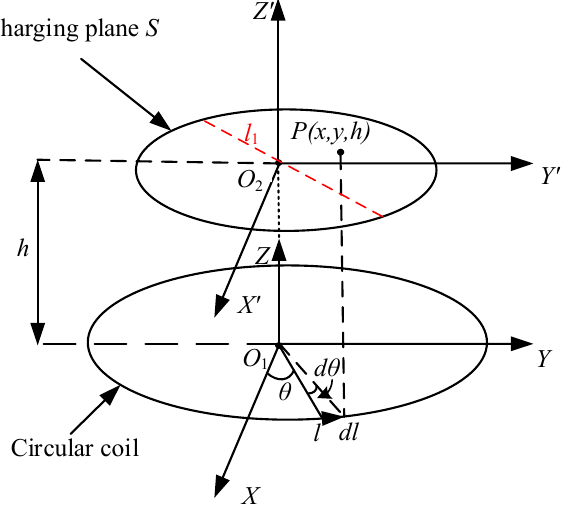
Circular coil Figure 1. Schematic diagram of charging plane S formed by the circular coil . Where θ is the included angle between O 1 l and the X -axis. When the Rx coil moves arbitrarily in the S -plane, the power “picked” by the Rx coil is determined by the magnetic induction intensity B Z in the Z direction generated by the Tx coil [15]. According to Biot–Savart’s Law, assuming that the current flowing through the circular coil is I , the B Z generated at any point P on the S -plane can be expressed as where μ 0 is the vacuum permeability. It can be seen from Equation (1) that the radius of the Tx coil a and the gap h determine the strength of B Z . The outer diameter of the Rx coil should fit the dimension of the AUV as closely as possible. Set the outer diameter of the Rx coil as 200 mm, when the AUV is recharged, the maximum radial misalignment is 30